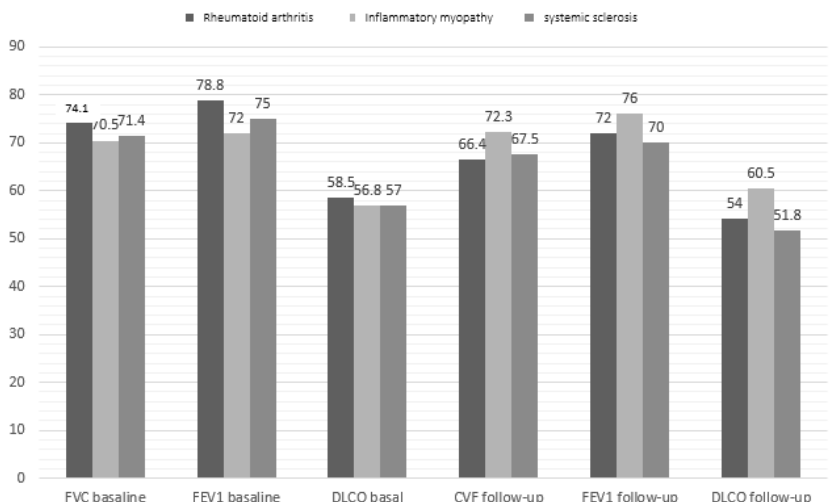
Figure 2. Changes in pulmonary function values by ILD-SAI subgroup. HRCT revealed disease progression in 72/204 patients (35.3%), whereas 44/204 (21.5%) met the criteria for progression of ILD and 29/204 (14.2%) died. Progression by HRCT was more pronounced in patients with RA and SS ( p = 0.002). Analysis of lung disease by subgroup revealed more frequent progression and death in 48/123 (39%), fol- lowed by 21/58 (36%) in those with SS and 4/23 (17%) in those with IM ( p = 0.016). Mean survival until progression and death was 136.3 (11.0) months, with a higher median value for IM than for SS and RA (median [95% CI], 171.7 [107.8–210.3] vs. 159.0 [137.9–174.7] vs. 111.3 [65.0–127.3] months; p = 0.017 [log-rank]). 3.3. Factors Associated with Progression of Lung Disease and Death in ILD-SAI Table 4 shows the results of the Cox multivariate analysis (dependent variable: pro- gression or death) performed in 204 patients with ILD-SAI over a median 56.5 (29.8–93.3) months. The outcome was progression or death in 73/206 patients. The multivariate anal- ysis revealed that smoking, UIP pattern, FVC < 80% at initiation of follow-up, and diag- nosis of RA vs. SS and IM were associated with a higher probability of progression of lung disease and death. Table 4. Cox regression model (adjusted for progression of ILD). Variable